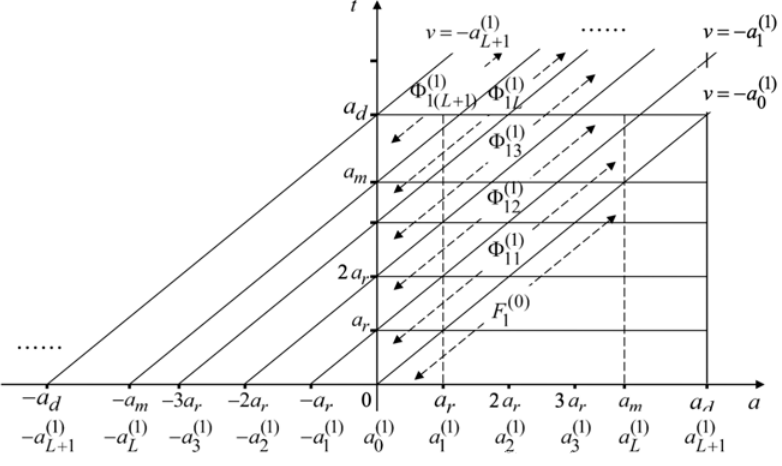
Fig. 2. Schematic diagram of definition of the sequence Φ (1)